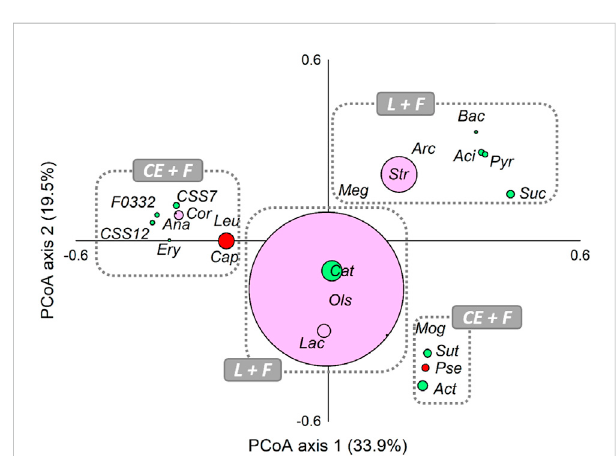
FIGURE 3 Principal Coordinate Analysis (PCoA), based on Bray-Curtis similarity index, of lactate-producing (L, pink), secondary fermentative (F,green),andchain-elongating(CE, red)coretaxaatgenuslevel( ≥ 5% in at least one sample). The size of dots is proportional to the relative abundance (average %) of each core taxa. Taxa ordinated closer to one other showed more similar variation patterns than those ordinatedfurtheraway.Aci, Acidaminococcus ;Act, Actinomyces